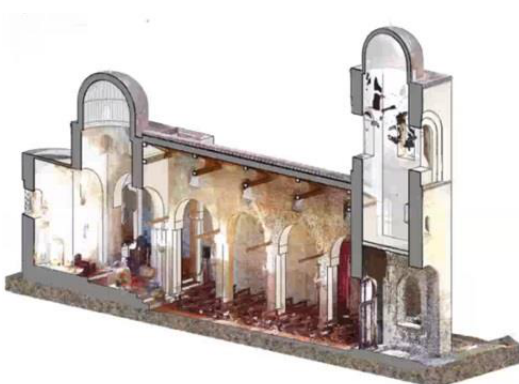
Figure 12. 3D View of the parametric model.